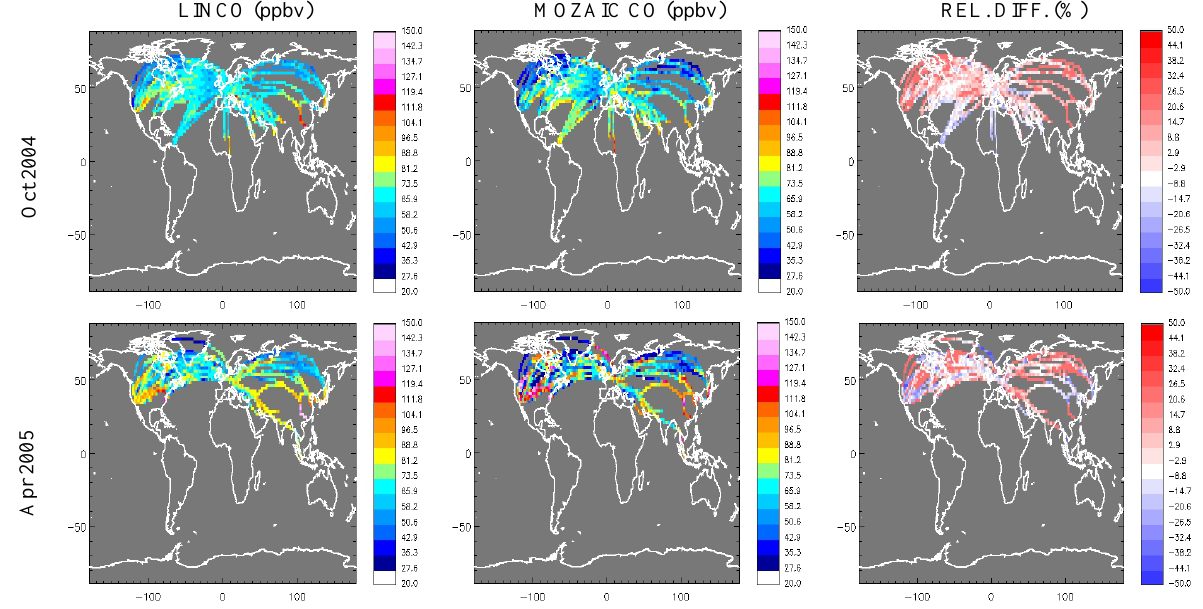
Fig. 8. CO fields from LINCO (left) and measured by MOZAIC aircraft (center) in parts per billion by volume (ppbv) and corresponding relative differences (%) (right) (Model-Obs)/Obs x100 in October 2004 (upper panel) and April 2005 (lower panel) for pressures between 300 and